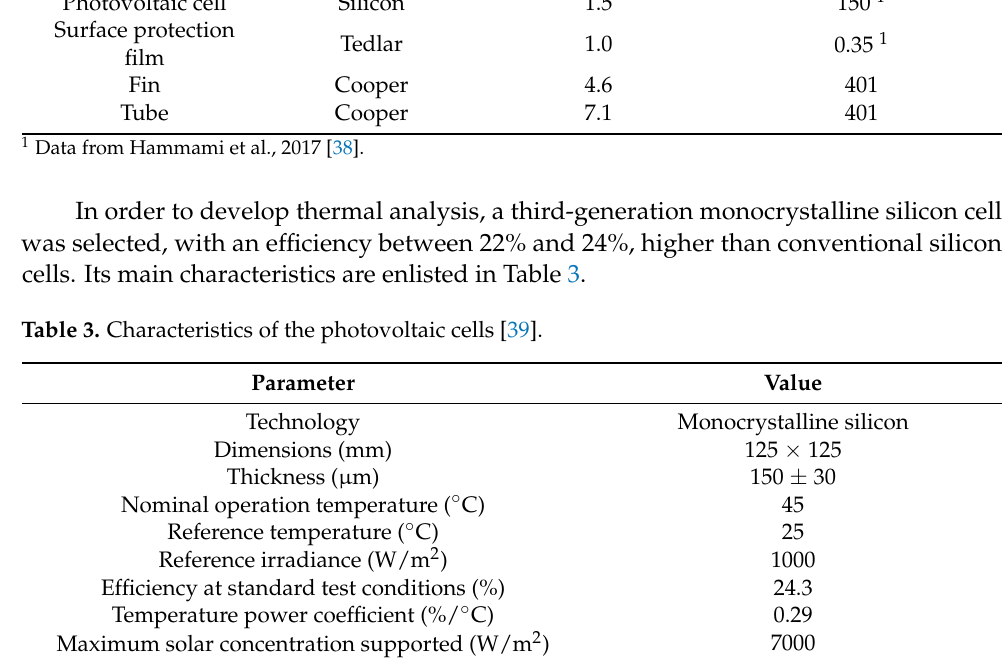
Table 2. Properties of the selected materials in the CPV/T receptor. Component Material Thickness (mm) Photovoltaic cell Silicon